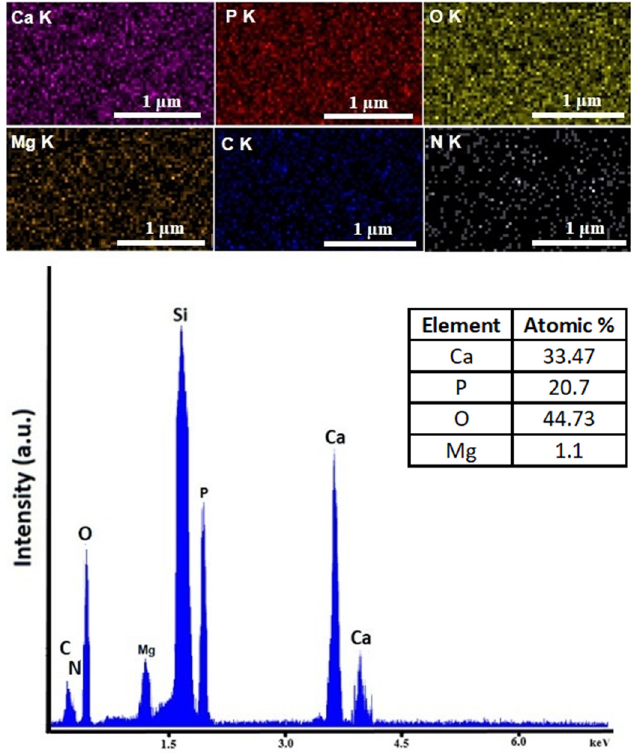
Figure 7. Elemental distribution cartographies of constituent chemical elements along with EDX spectra of 10 MgHApCh-0 thin films.